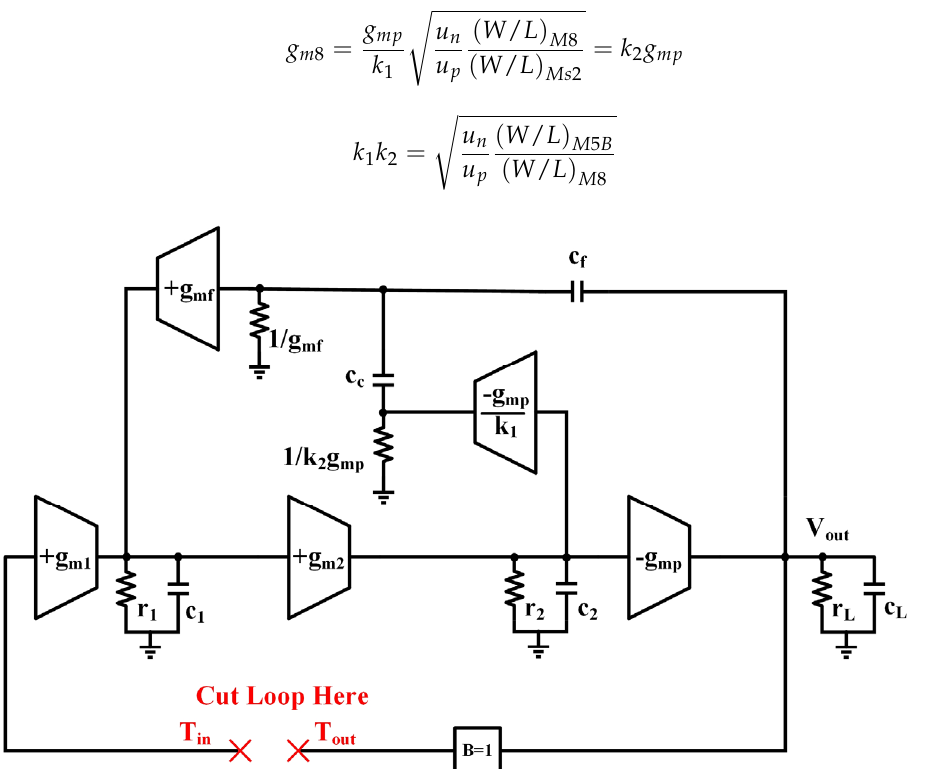
Figure 4. Small-signal block diagram of the proposed LDO.